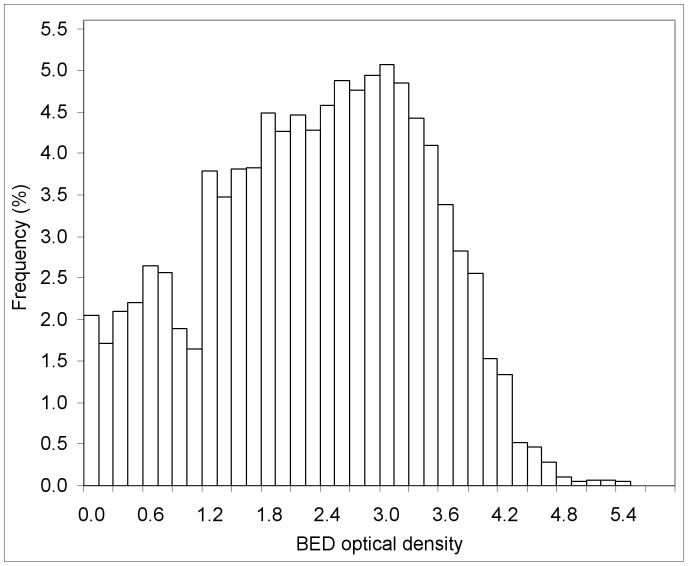
Distribution of BED optical density among women at recruitment into the ZVITAMBO Trial.